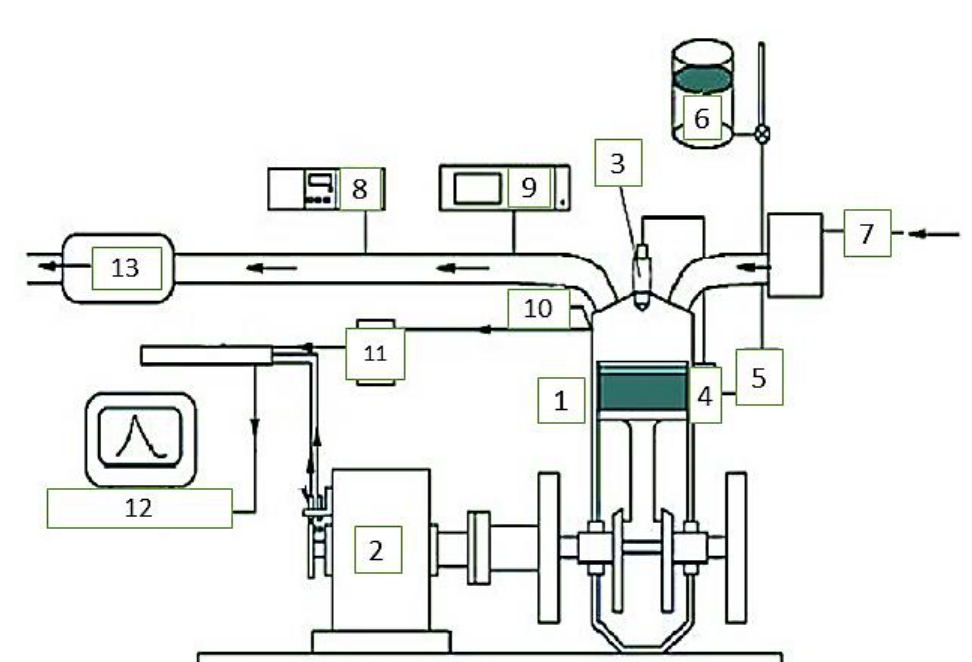
Figure 2. Experimental setup for engine performance and emission measurement.